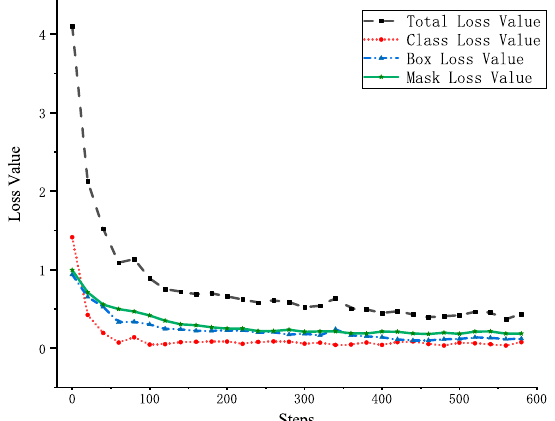
Figure 8. Trend of four loss values during 30 epochs.